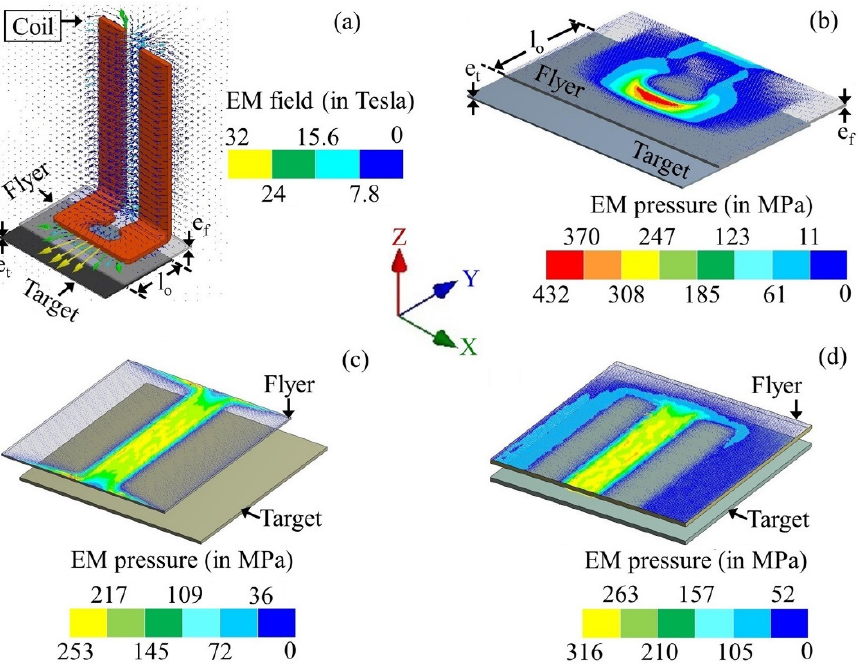
Figure 4. Calculated ( a ) EM field intensity and ( b ) EM pressure distribution with an O-shaped flat coil, and EM pressure distribution with a ( c ) H/I-shaped flat coil and ( d ) E-shaped flat coil for an applied energy of 13 kJ and at a time instant of 11 µs for MPW of a 1.2 mm (e f ) flyer and 0.8 mm (e t ) target.